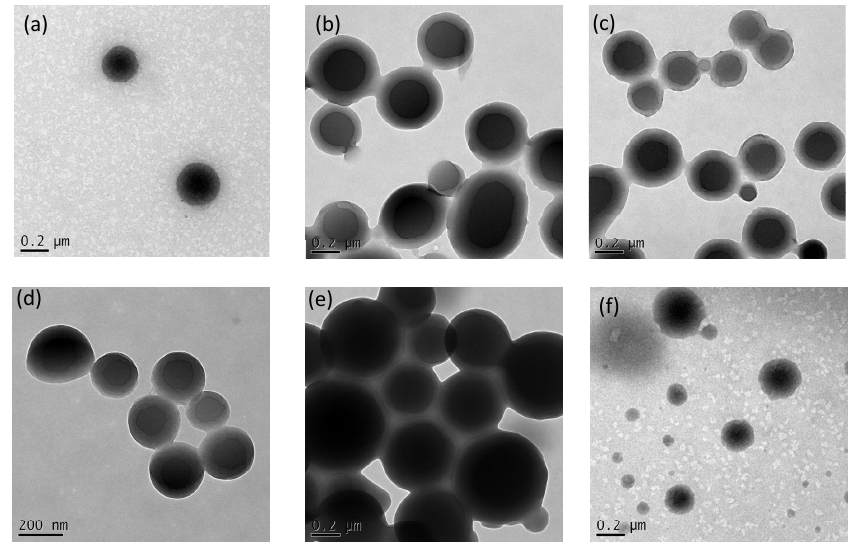
Figure 12. TEM images of PVBT/PVBA blend complexes in DMF solution: ( a ) 10/90; ( b ) 30/70; ( c , d ) 50/50; ( e ) 70/30; and ( f ) 90/10.